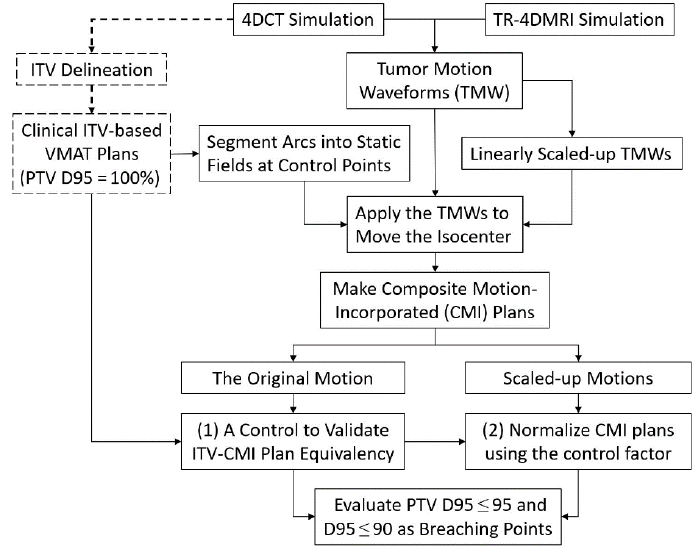
Figure 1. The flowchart of the motion-incorporated planning study. The dashed-lined sections are clinical VMAT planning, while the solid sections are performed in this study. The PTV D95 is used to compare the plan quality equivalency between ITV-based clinical VMAT plans and the motion-incorporated study plan with original tumor motion from 4DCT. The motions that trigger the PTV dose breaching points (D95 = 95% and 90%) are analyzed and reported.